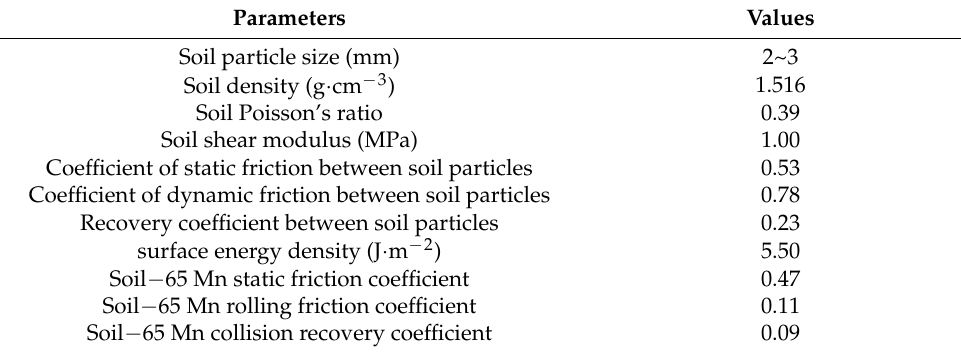
Table 1. Parameters of DEM virtual simulation test